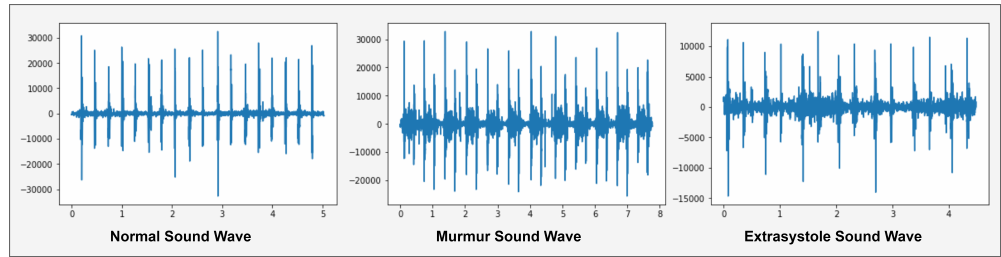
Figure 3. Graphical representation of Heartbeat sound signal.